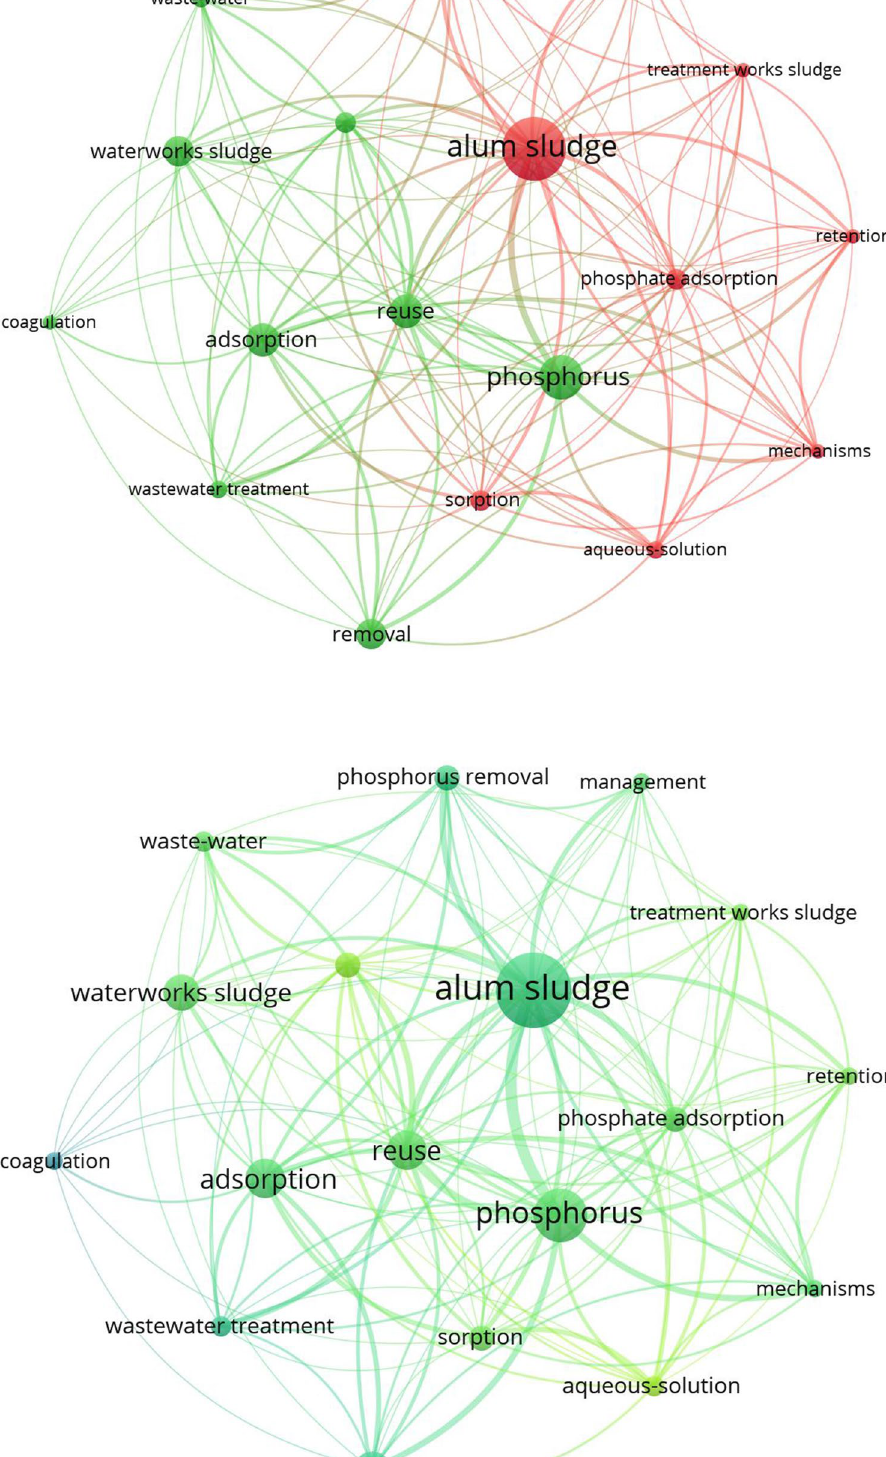
zation of alum sludge research work in the last two decades based on “Web of Science” platform to signify the research clusters using 1509 results obtained through data from “Web of Science” core collec- tion from the search terms “TI (alum sludge OR aluminium sludge OR waterworks sludge)”